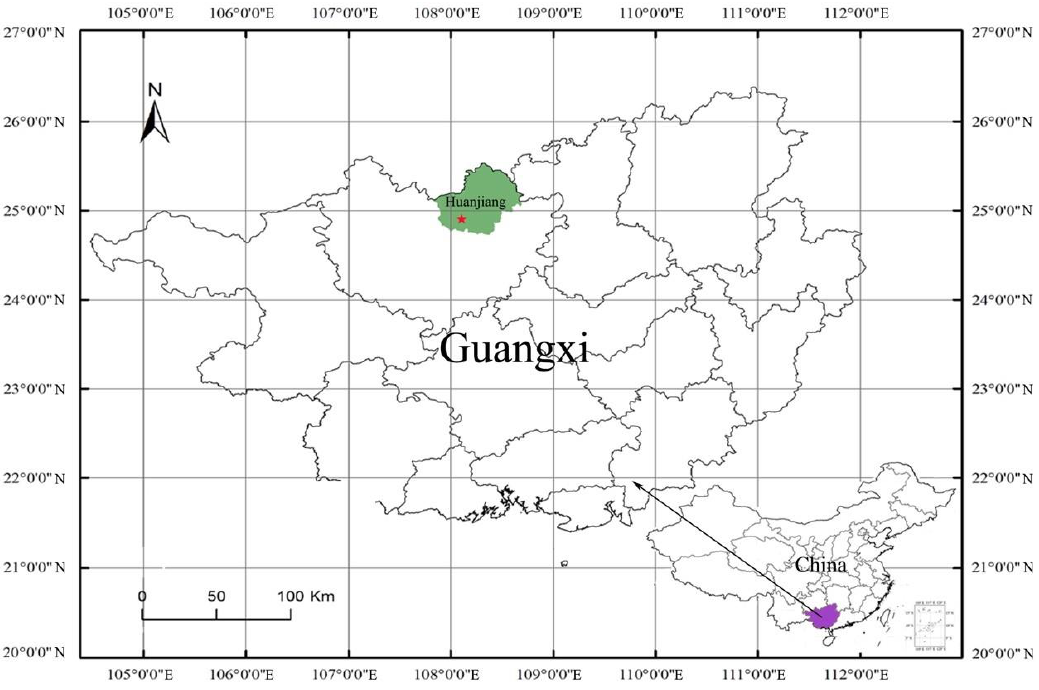
(cid:70) ) where we collected